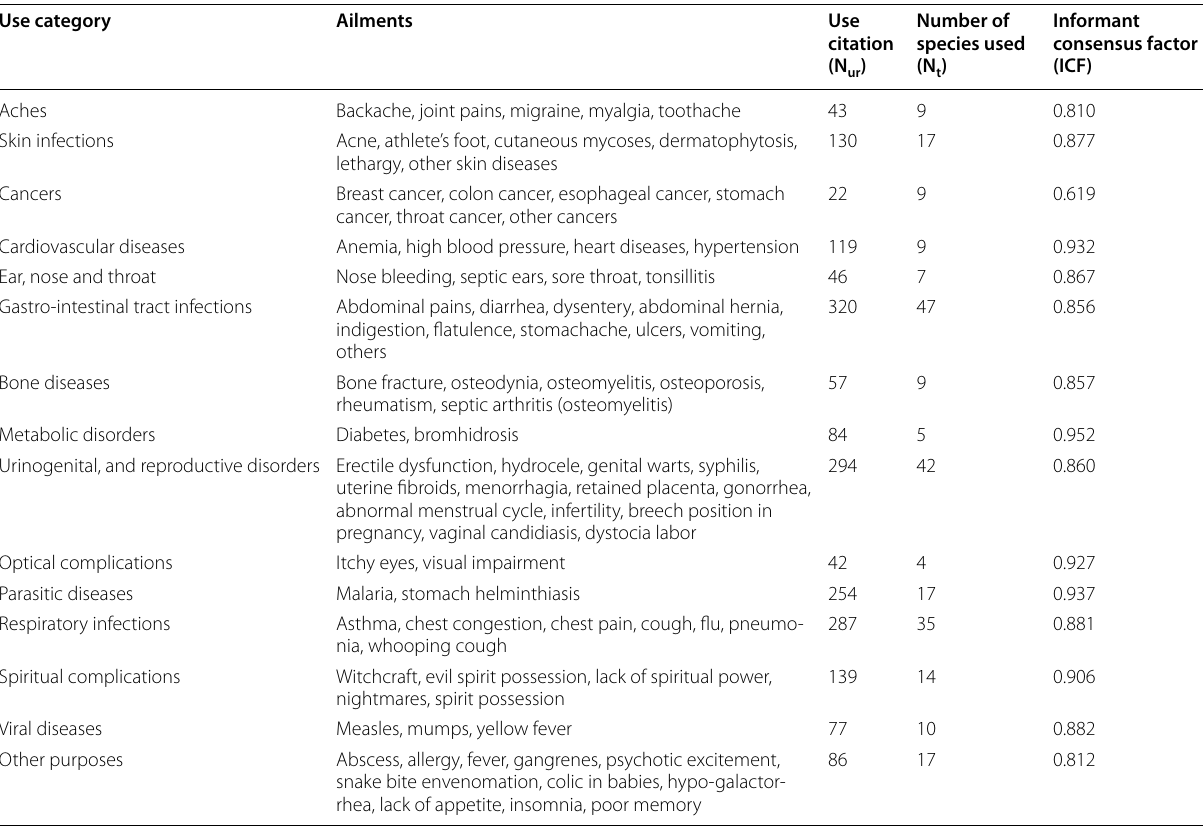
Table 3 Informant consensus factor by categories of diseases in Butaleja District Use